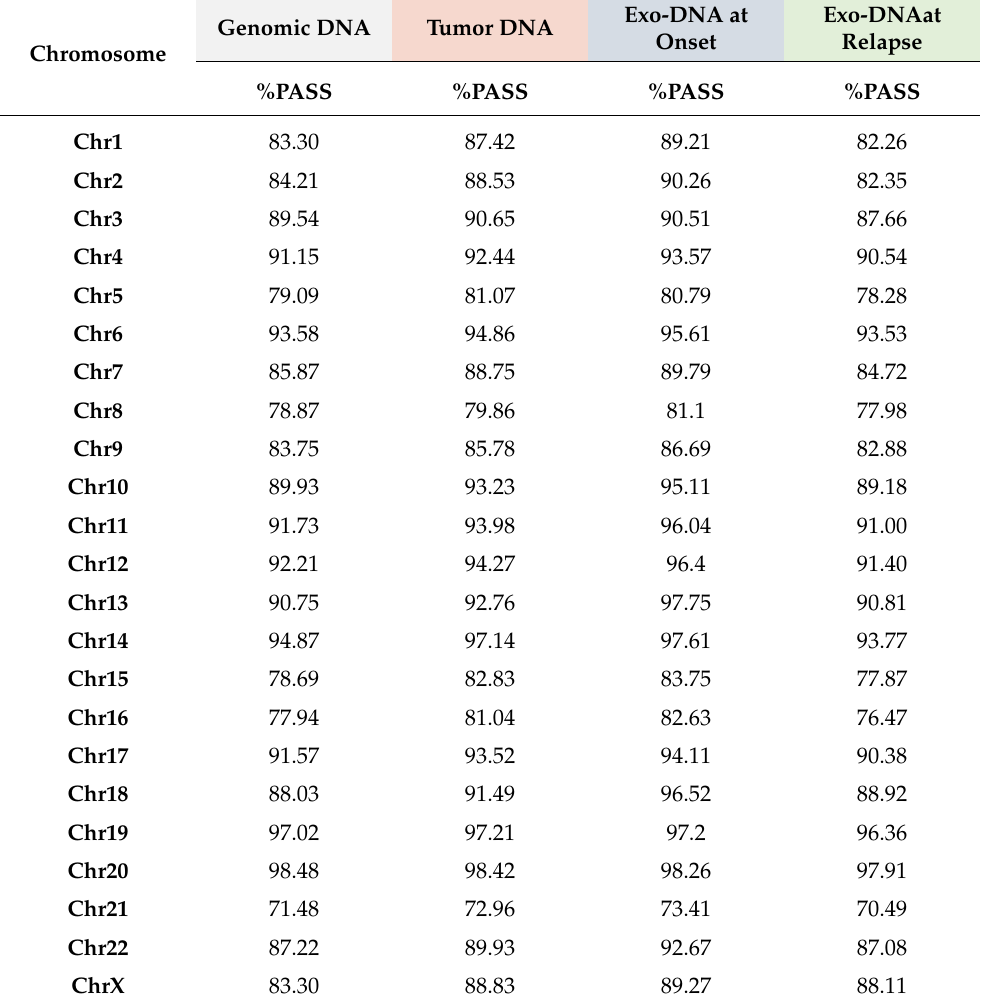
Table 2. Genotypability values of whole-exome sequencing (WES) managed on genomic blood DNA (gDNA), tumor DNA, and exosomal DNA